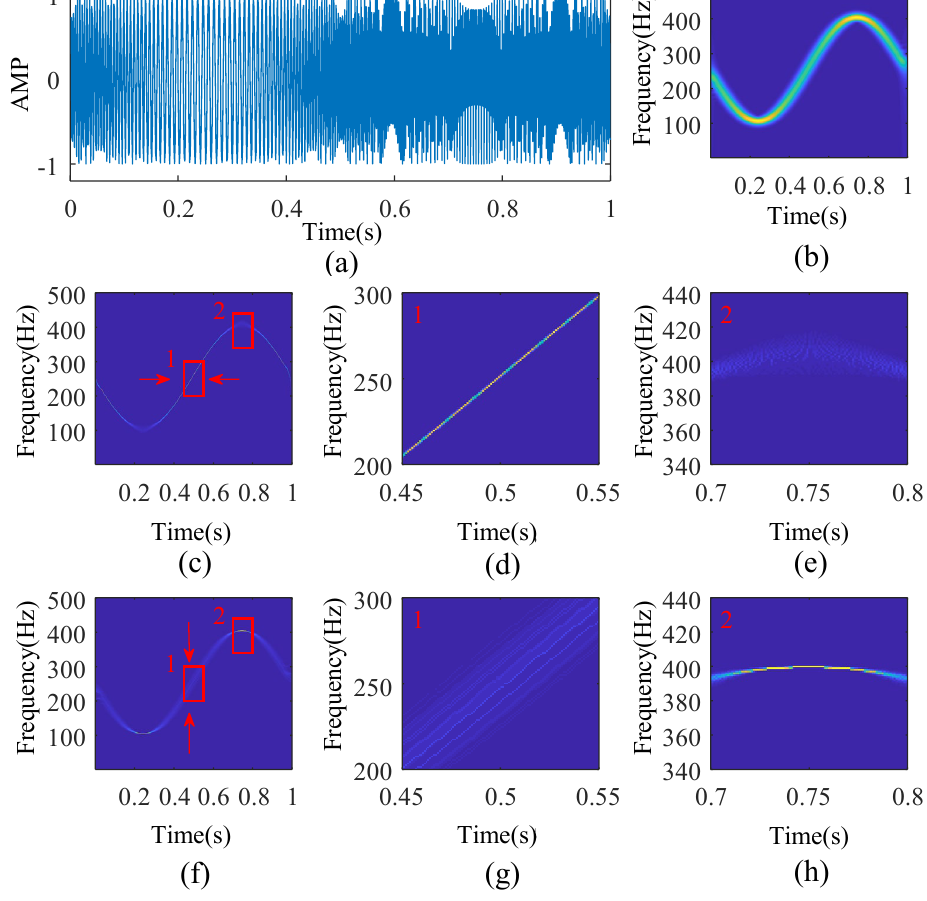
Figure 2. Time–frequency analysis and comparison of simulation signals: ( a ) time–domain waveform of simulation signal x e ( t ) : ( b – f ) are STFT, TMSST and MSST time–frequency images of simulation signals, respectively; ( d , e ) are enlarged images of regions 1 and 2 in ( c ), respectively; ( g , h ) are respectively enlarged images of regions 1 and 2 in ( f